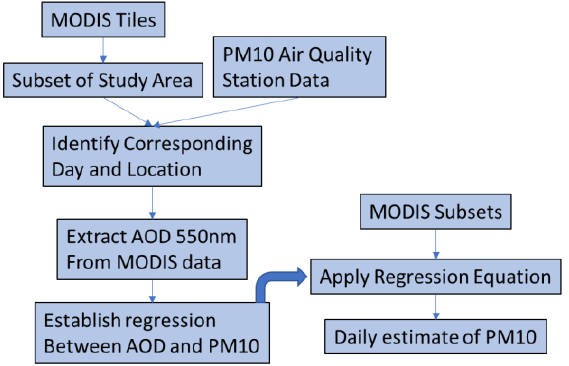
Figure 2 . Processing approach.